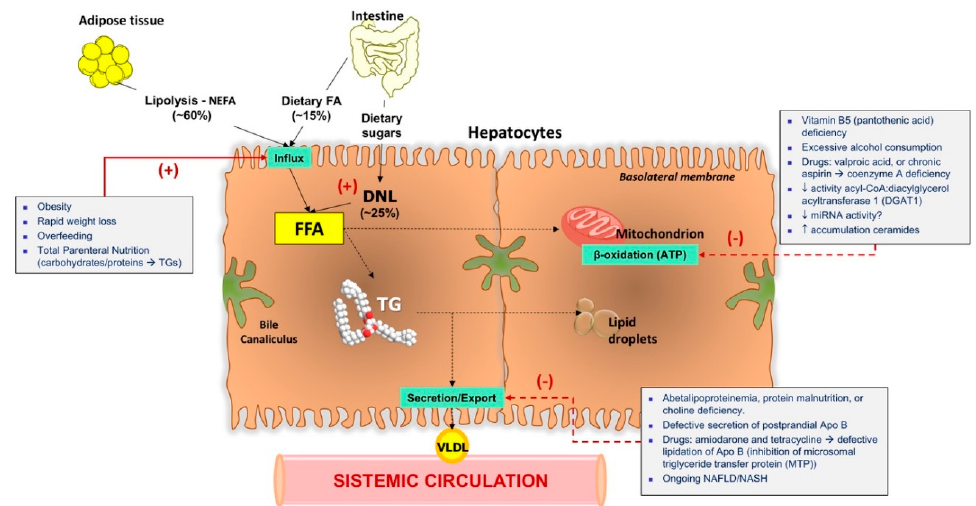
Figure 2. Mechanisms of lipid accumulation in the liver. In health, free fatty acids (FFA) originate from lipolysis of triglycerides (TG) in adipose tissue leading to circulating non-esterified fatty acids, (NEFA, ~60%), from dietary fatty acids (~15%), and from dietary sugars undergoing de novo